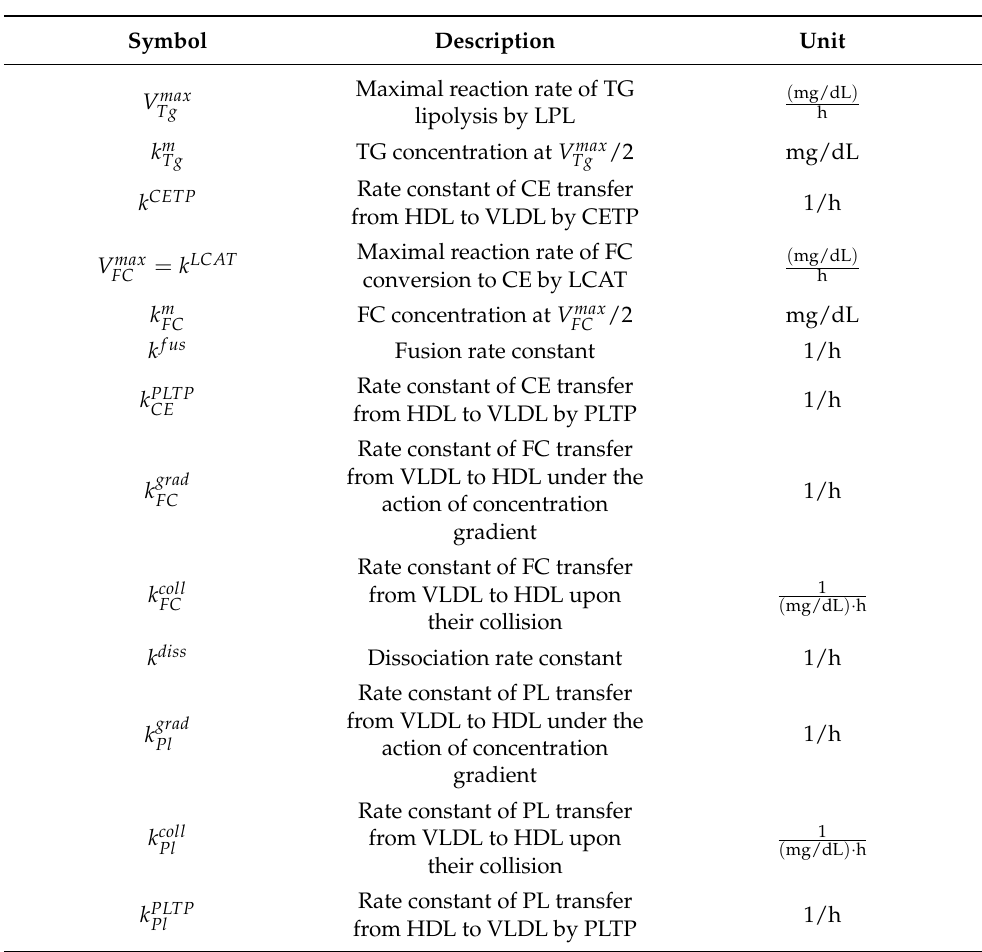
Table 4. Variables and rate constants used in the